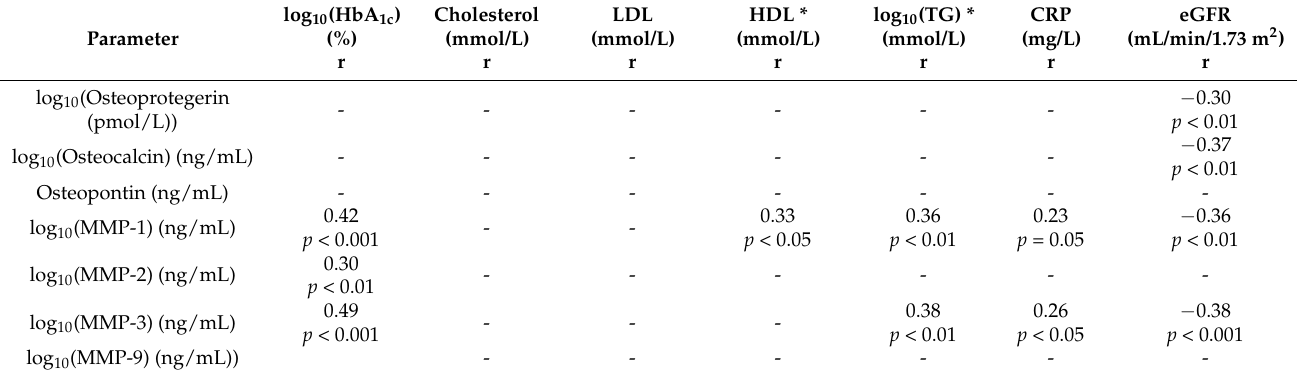
Table 2. Factors influencing concentrations of circulating markers of vascular remodeling—univariate linear regression